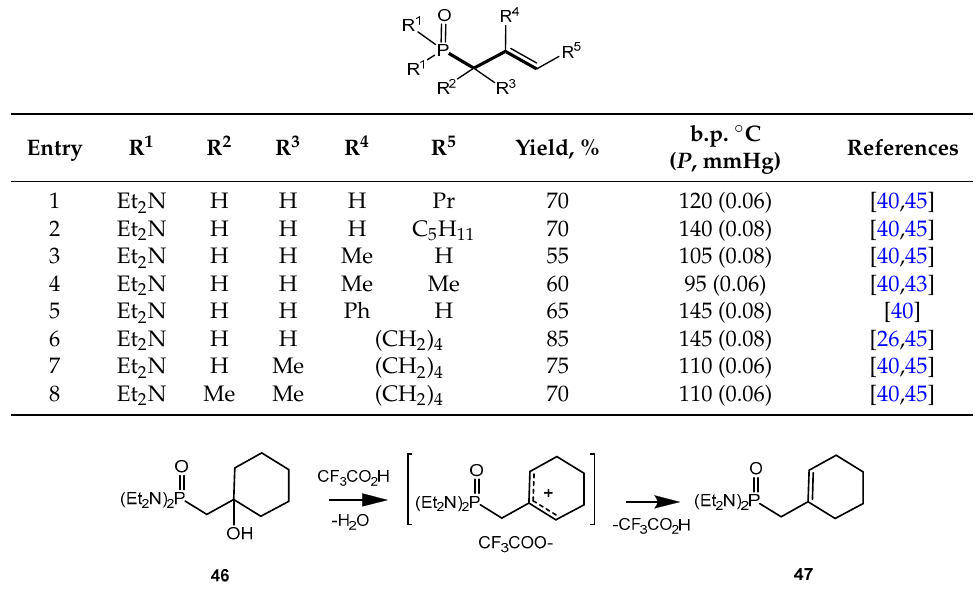
Table 8. Allylphosphonates 28 .